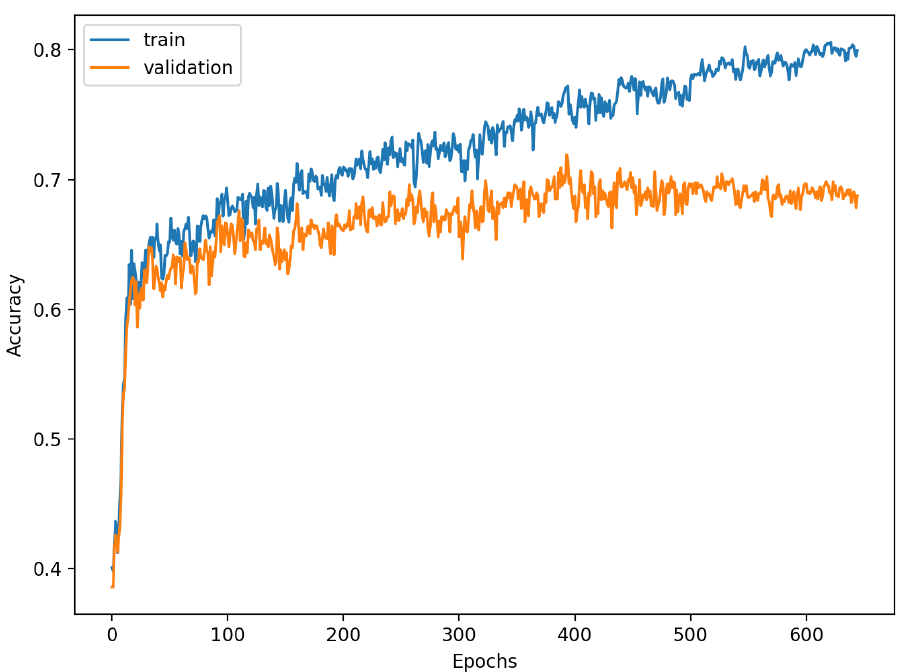
Figure 16. Learning process of the Neural Network for Few-Shot (5 classes) with proximity-based